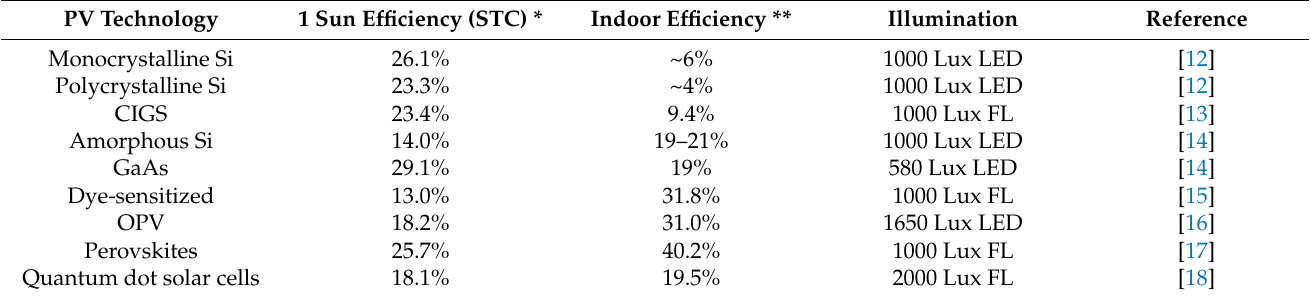
Table 1. Reported maximum power conversion efficiencies of the main PV technologies under solar illumination (AM1.5G solar spectrum) and under typical indoor illumination